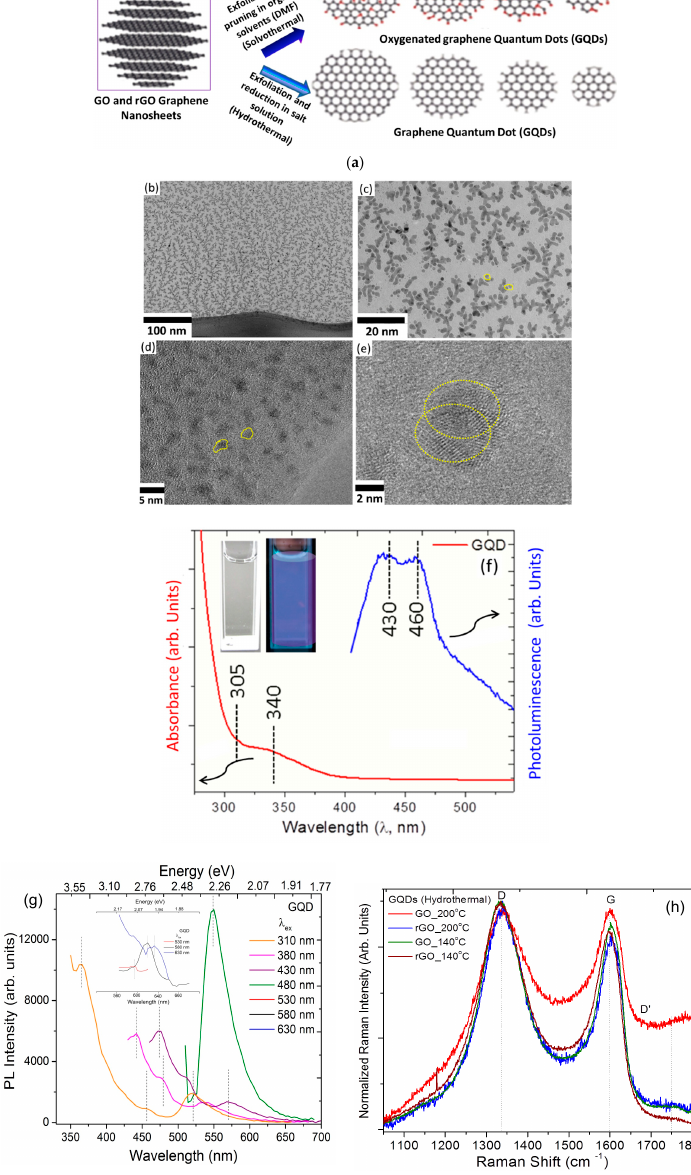
Figure 1. ( a ) Synthesis schemes for graphene quantum dots (GQDs) (top arrow; solvothermal) from exfoliation or pruning of GO in organic solvent (dimethylfluoride; DMF) and (bottom arrow; hydrothermal) exfoliation and reduction of GO (and rGO) in hydrothermal method resulting in GQDs of different sizes; ( b – d ) HR-TEM images of GQDs synthesized from scheme (a, top arrow) in different image resolution from 100 nm to 2 nm highlighting uniform dispersion and two isolated GQD overlapped depicting average size 5 nm (scale bars shown at the bottom of the images); ( f ) UV-Vis absorption (190–550 nm) and room temperature photoluminescence spectrum of GQD showing optical emission in blue-violet region (inset shows GQD vials without (clear) and with (blue violet) UV lamp); ( g ) photoluminescence excitation (PLE) spectra of GQDs; and ( h ) micro-Raman spectra of GQDs hydrothermal synthesized at two different temperatures using GO and rGO